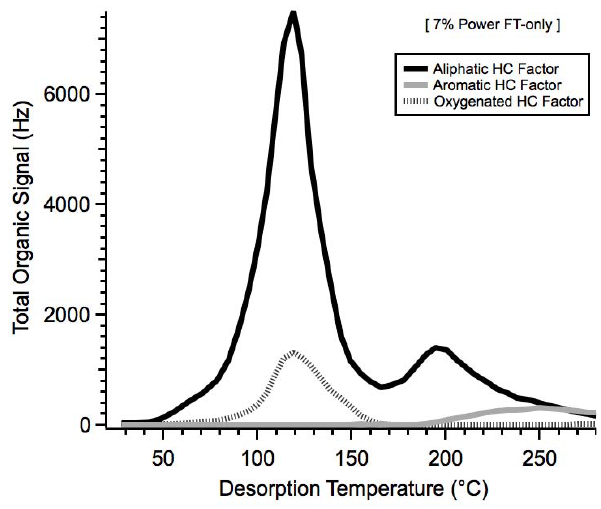
Fig. 9. Desorption profiles of emissions from a single engine burn- ing FT fuel only (7% power). The three PMF factors are the same as shown in Fig.